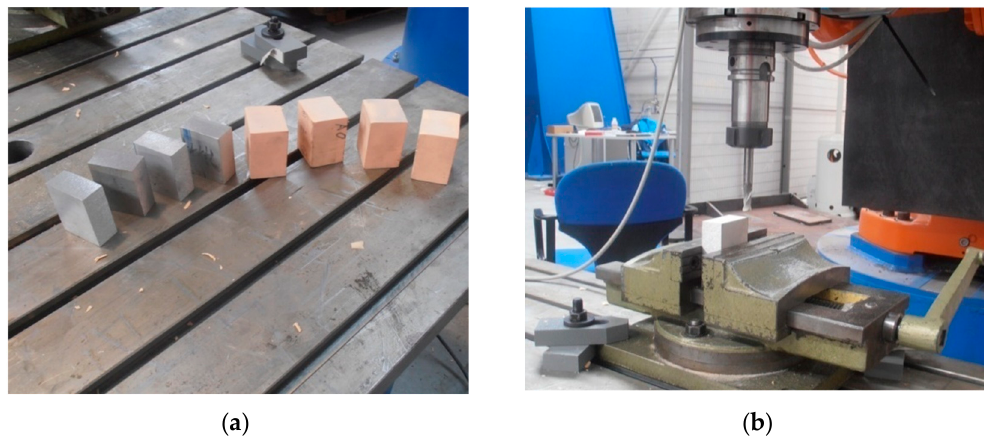
Figure 5. ( a ) Workpiece before machining; ( b ) execution of the machining tests.